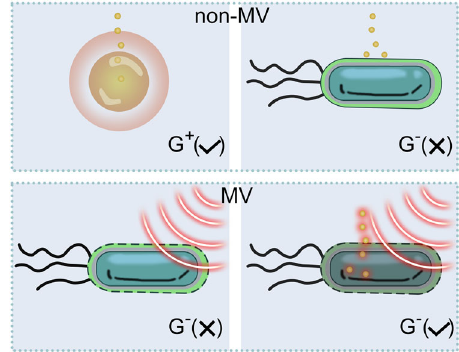
Fig. 1 Antibacterial performance of GNs with or without MV. GNs are sensitive to S. aureus , but due to the presence of outer membrane (OM) in E. coli , GNs have no effects on E. coli . After applied MV, nanopores generated in OM can induce GNs to enter the bacteria, and the subsequent synergy of GNs and its MV thermal effect plays a bactericidal effect. G + Gram-positive bacteria, G − : Gram-negative bacteria, ✓ : dead, ×: